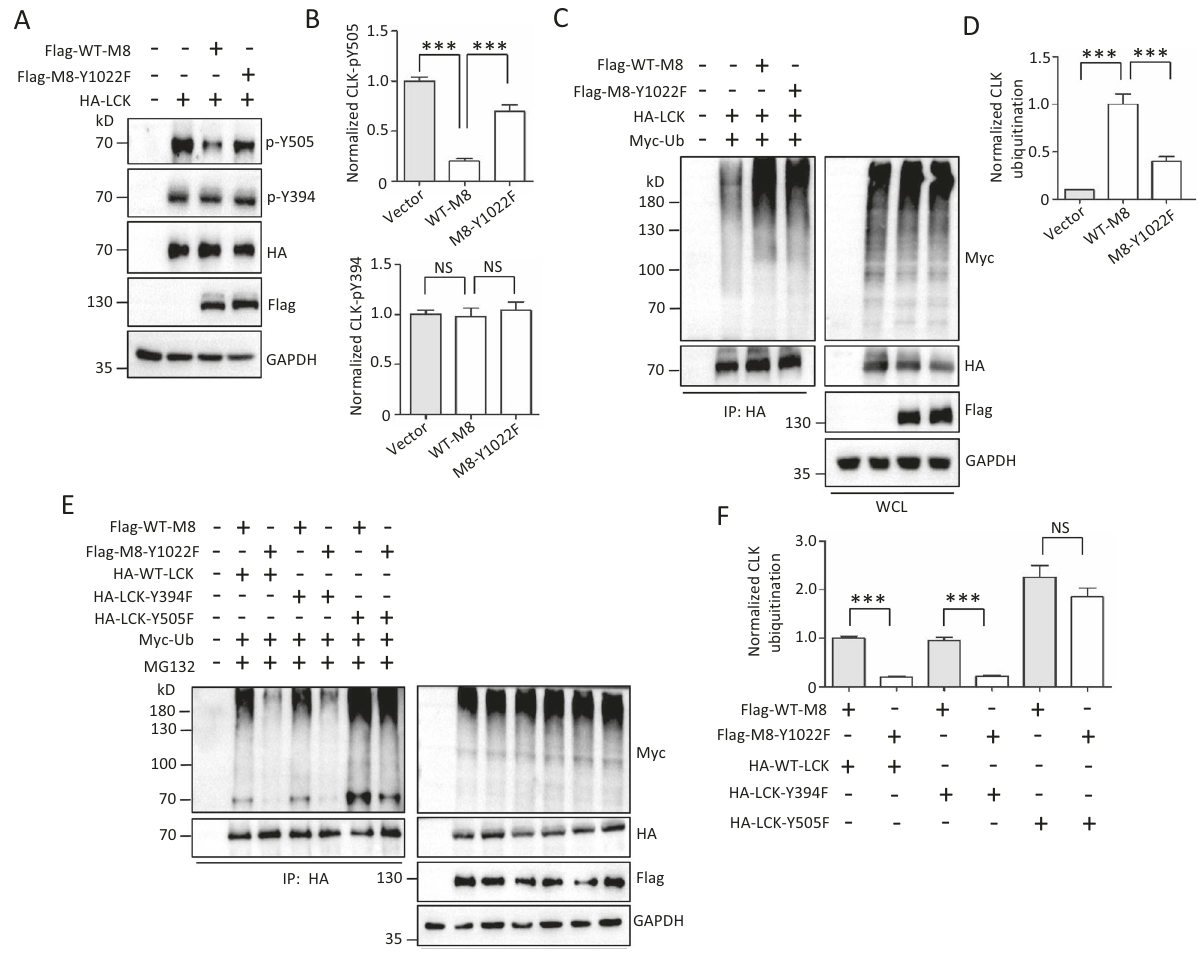
Fig. 7 LCK activity regulated by TRPM8 phosphotyrosine. A , B LCK phosphorylation assay. PANC-1 cells were co-transfected HA-LCK with the control vector, WT-TRPM8 or mutant TRPM8-Y1022 with the indicated antibodies as shown in ( A ), and quanti fi cation of the level of LCK phosphorylation shown in ( B) . C – F LCK ubiquitination assay. C , D Expression constructs for HA-LCK and Myc-Ub were co-transfected with control vector, WT-TRPM8 or mutant TRPM8-Y1022 into AsPC-1 cells. The cells were treated with 10 μ M MG132 for 6 h before harvest and used for IP with an anti-HA antibody and WB with the indicated antibodies. E , F Expression constructs for Myc-Ub and WT-TRPM8 or mutant TRPM8- Y1022F were co-transfected with HA-tagged wild-type or mutant LCK into PANC-1 cells. The cells were treated with 10 μ M MG132 before harvest and used for IP with an anti-HA antibody and WB with the indicated antibodies. *** P < 0.001, NS not signi fi cant. Data are presented as mean ± SEM. All studies were repeated at least three